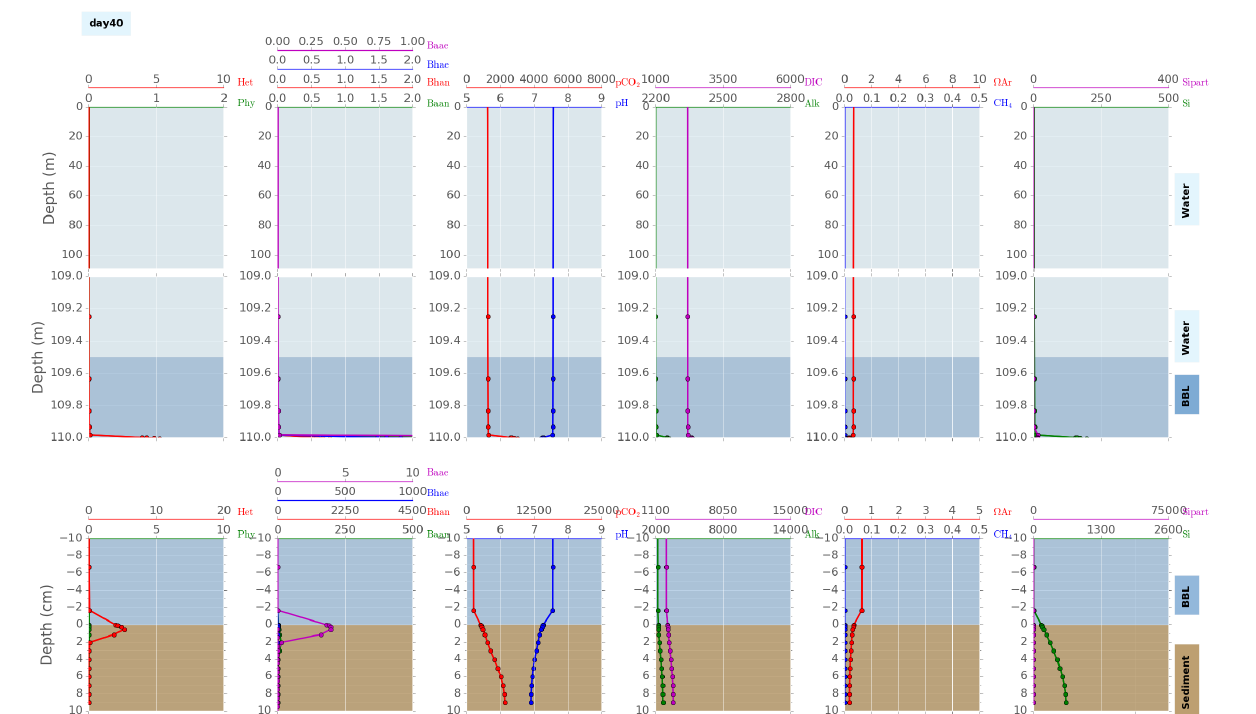
Figure 3. Vertical distributions of the modeled chemical parameters (µM), biological parameters (µM N), temperature ( ◦ C), salinity (PSU), and vertical diffusivity (10 − 3 m 2 s − 1 ) during the winter period of well-mixed conditions, showing the water column (light blue), the benthic boundary layer (dark blue), and the sediments (light brown).